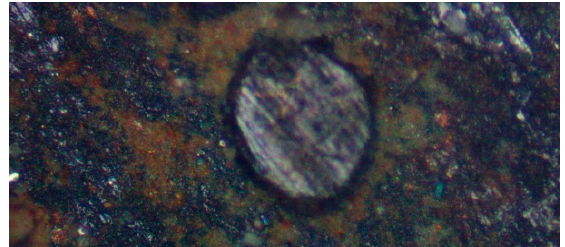
Figure 4. ST Trial Pellet (ST1c [16]) Following Desalination: Reflected Light; Halite infilling circular pore on polished cut surface. The halite infilling the circular carrier pore shows a characteristic “ kristallbrocken ” texture [49] indicating that the pore was infilled by crystal masses growing out from the pore boundaries. The bulk of the matrix in the photomicrograph is constructed from goethite [41–48]. All the pores are infilled with halite. The blue lath shaped crystals are atacamite. Field of view = 0.52 mm; ZVI:water ratio = 25.34 g/L; Feed water salinity = 8.19 g/L; Product water salinity after 230 days = 2.28 g/L. NaCl removed = 5.91 g/L (0.23 g/g ZVI). Feed water pH = 6.21; Product water pH = 8.54.